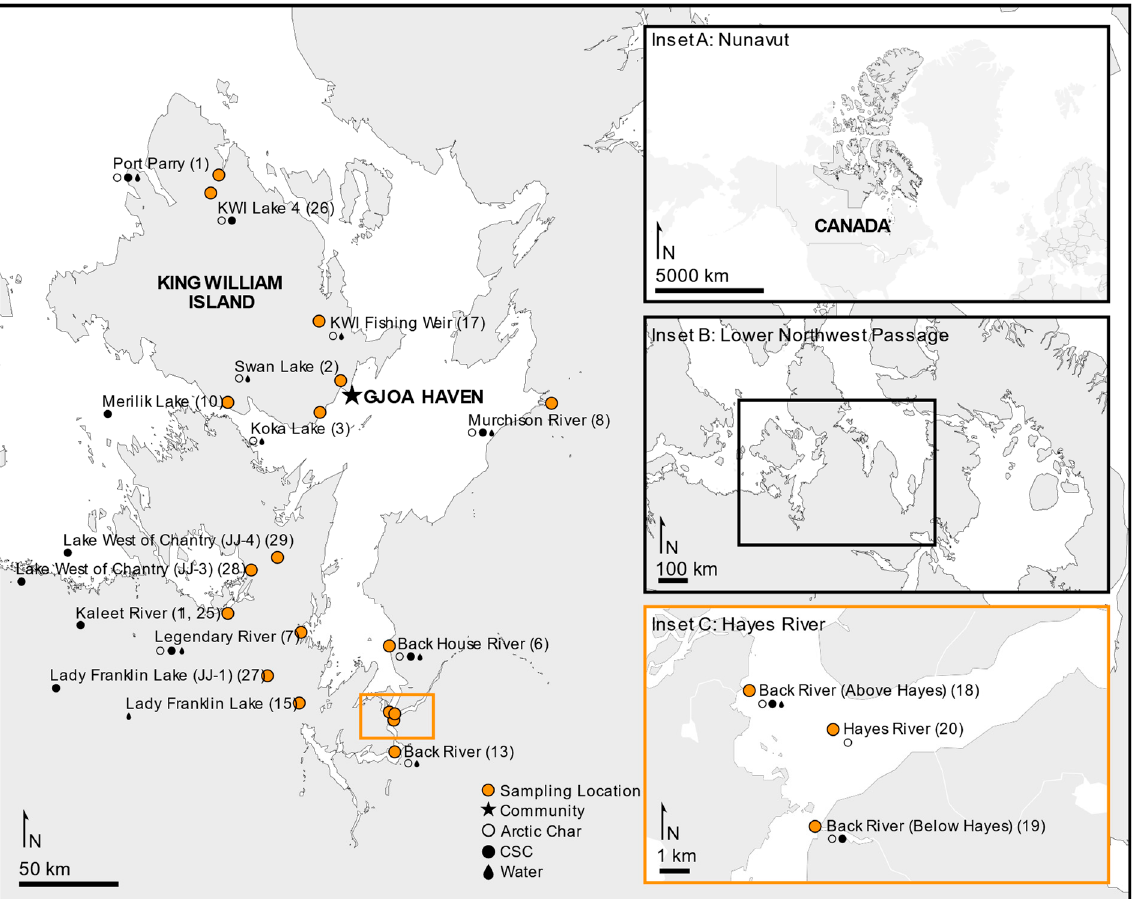
Figure 1. Study area of the lower Northwest Passage located in the Kitikmeot region within the Canadian territory of Nunavut. Sampling sites are shown indicating where fished Arctic char (open circles), members of the Coregonus species complex (CSC; closed circles) or water (dark drop) was collected. Map produced using ArcGIS Online and A ffi nity Designer.